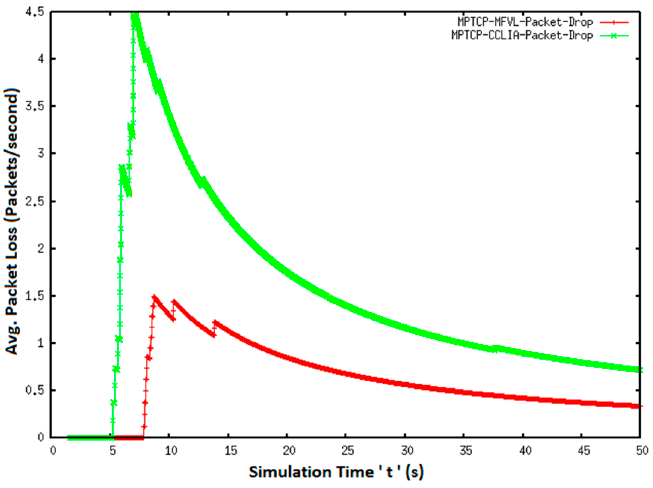
Figure 14. Average packet drop rate of Setup 3.